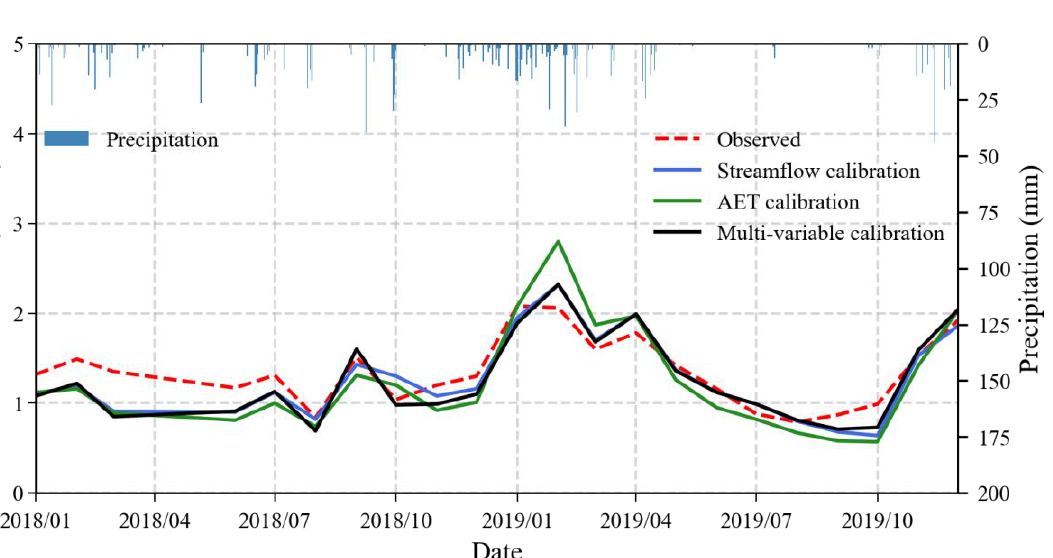
Figure 4. Simulated versus measured MODIS evapotranspiration for each calibration scenario at catchment scale. 3.2.1. Streamflow Calibration The streamflow calibration showed good results in general for streamflow (NSE = 0.71; R 2 = 0.84; PBIAS = 5.6%) (Table 3). The results regarding evapotranspiration were unsatisfactory for NSE (NSE within −0 .17 to 0.57), except for sub-basin 8 (NSE = 0.57), and satisfactory for R 2 and PBIAS (R 2 > 0.58; PBIAS within −1 2.7% to 15.8%). Figure 3 desig- nates a satisfying match between measured and simulated streamflow except for low flows during the dry season. However, the temporal dynamics of the hydrograph were generated correctly. Figure 4 indicates differences between observed and simulated AET. Streamflow calibration underestimated evapotranspiration in the wet season and overes- timated evapotranspiration at the beginning of the dry season. 3.2.2. Actual Evapotranspiration Calibration The AET calibration presented unsatisfactory performance for NSE for sub-basins 2 – 7 and satisfactory performance for sub-basins 1, 8, 9, 10, and 11 (NSE within −0 .14 to 0.58) (Table 3). In respect of R 2 and PBIAS, the results were satisfactory for all the sub-basins